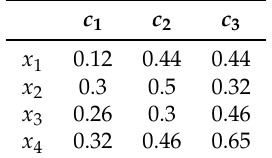
Table 12. R 4 : opinion of expert m 4 .